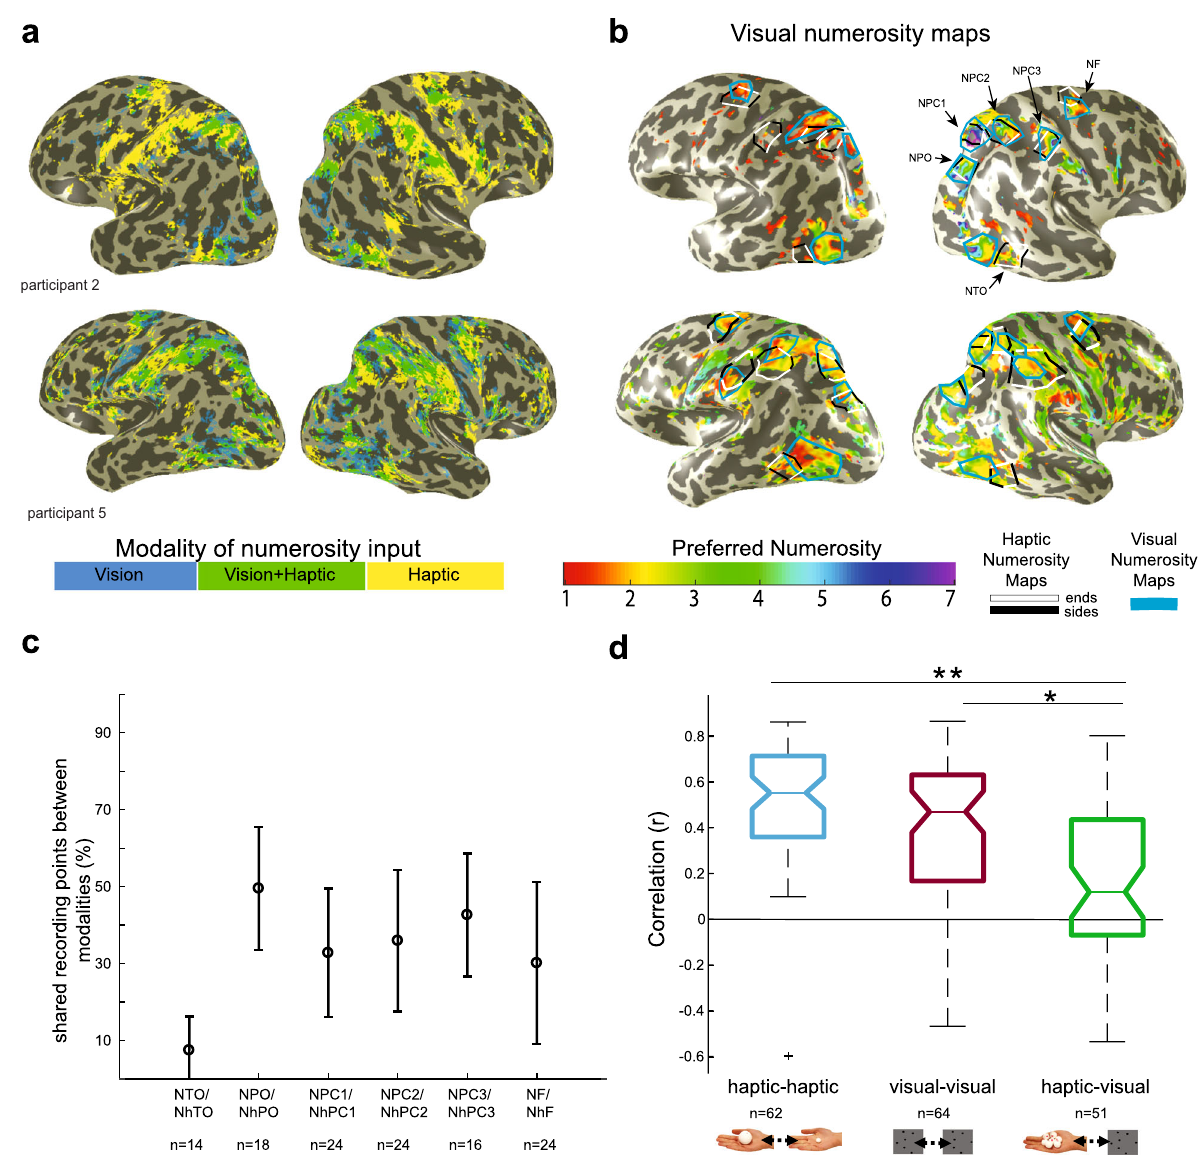
Fig. 5 Numerosity-selective responses are modality-speci fi c. a Neural responses driven by visual and haptic numerosity stimuli largely overlap. Colors in each data point represent which type of sensory input produced numerosity-selective neural response (as captured by the pRF model with variance explained >30%). b Maps of preferred visual numerosities with the outlines of the visual and haptic numerosity maps shown in blue and black/white lines respectively. The topographic numerosity maps of the two modalities only partially overlap. c Percentage of overlap between the visual and haptic numerosity maps relative to the map sizes averaged across participants, hemispheres, and modalities (i.e., visual and haptic numerosity maps). Error bars show the standard deviation of the mean. n indicates the number of maps that were averaged together. d No systematic relationship between the two modalities was found between participants or maps. A box-plot diagram shows the distribution of correlation coef fi cient values ( r ) that were obtained from the analyses of correlation between the two haptic stimulus con fi gurations, the visual test – retest and the correlation between preferred haptic and visual numerosities in their shared areas (right). Stars show signi fi cant differences between groups in post hoc test for multiple comparisons (Bonferroni correction; * indicates p adj = 2 × 10 − 5 ; ** indicates p adj = 1.9 × 10 − 9 ). The average of the correlation coef fi cients of each part of the data was signi fi cantly higher than zero (one-sample t test: two haptic stimulus con fi gurations: t (61) = 14, p = 9.8 × 10 − 21 ; visual test – retest: t (63) = 9.75, p = 3.2 × 10 − 14 ; haptic and visual: t (50) = 3.18, p = 0.0025). In the box-plot diagram, the central mark indicates the median, and the bottom and top edges of the box indicate the 25th and 75th percentiles, respectively. The whiskers extend to the most extreme data points not considered outliers, and the outliers are plotted individually using the “ + ” symbol. n indicates the number of maps that were grouped